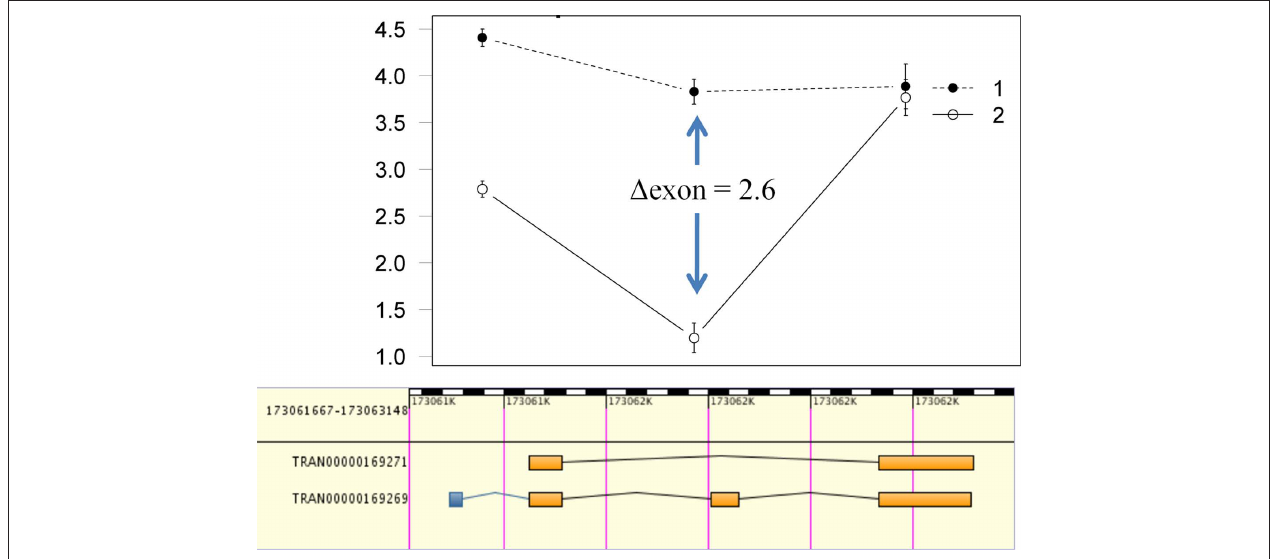
FiguRe 4 | Visualization and concordance of putative alternative splice candidates. Data for putative alternative splice candidates can be visualized via interaction plots with the log2 intensity on the Y axis and Ensembl exons on the X axis. The plots can then be aligned with entries from ASTD to determine if there is concordance between putative alternative exon usage from the computational detection framework and known splice events (such as the cassette exon in this